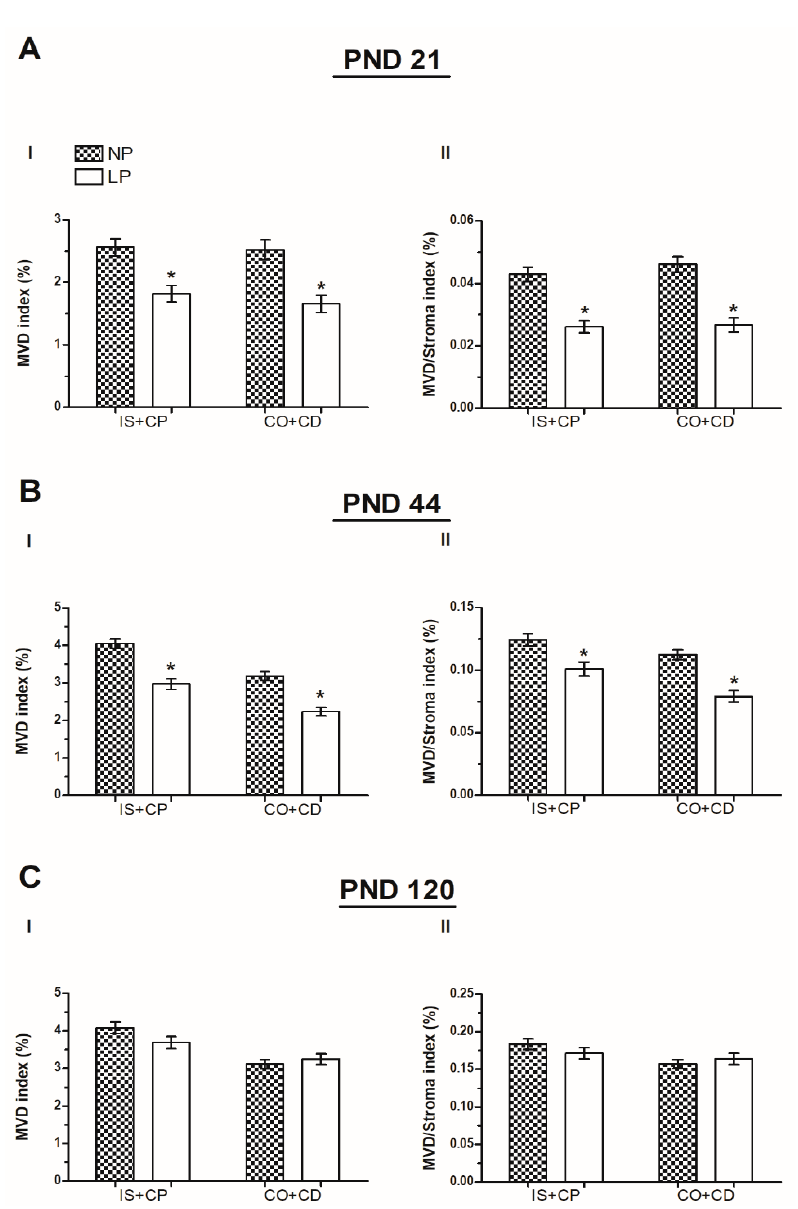
Figure 3. The microvascular densities. ( A ) microvasculature density (MVD) index ( I ) and MVD/Stroma index ( II ) in the IS+CP and CO+CD of 21 ‐ day ‐ old animals. ( B ) MVD index ( I ) and MVD/Stroma index ( II ) in the IS+CP and CO+CD of 44 ‐ day ‐ old animals. ( C ) MVD index ( I ) and MVD/Stroma index ( II ) in the IS+CP and CO+CD of 120 ‐ day ‐ old animals. Data are presented as means